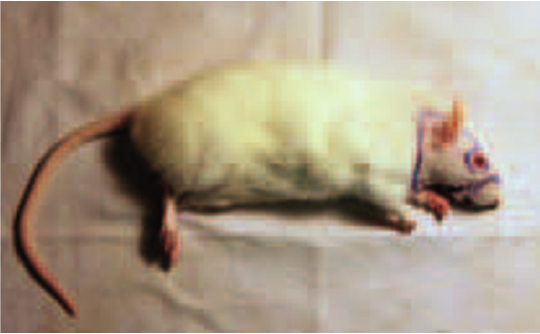
Figure 4. The recipient rat Wistar